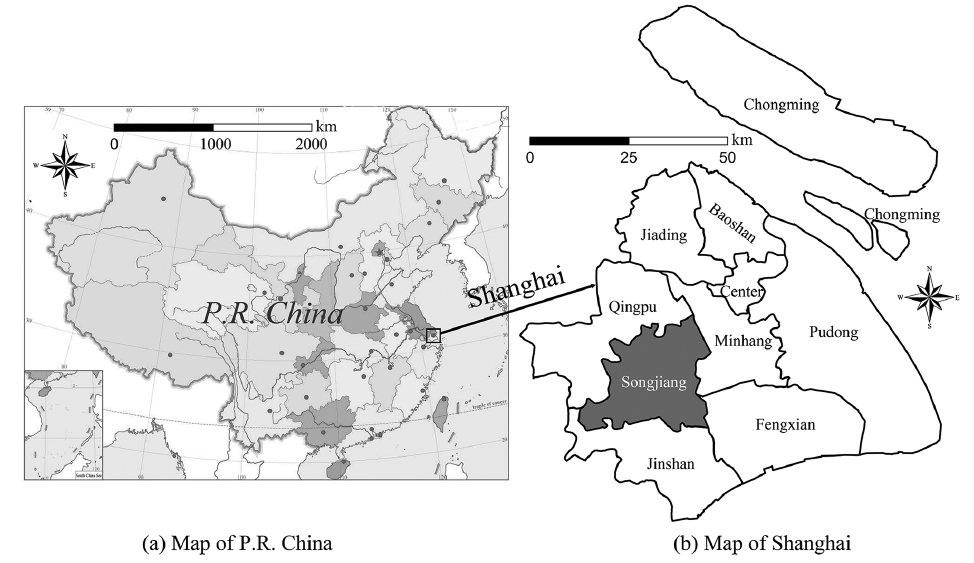
Figure 1. The study area of Songjiang district in Shanghai, China. ( a ) Map of P. R. China and ( b ) Map of Shanghai.